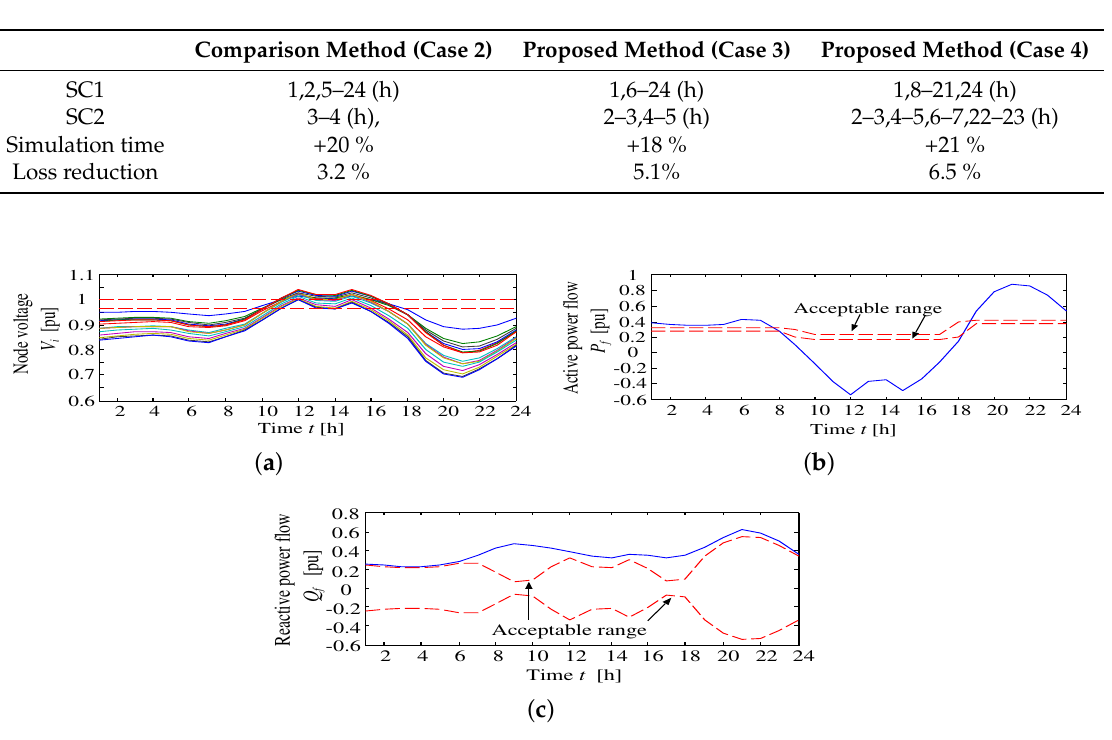
Figure 8. Simulation results without optimization (Case 1). ( a ) Voltage profile without control, ( b ) active power flow at the interconnection point and ( c ) reactive power flow at the interconnection